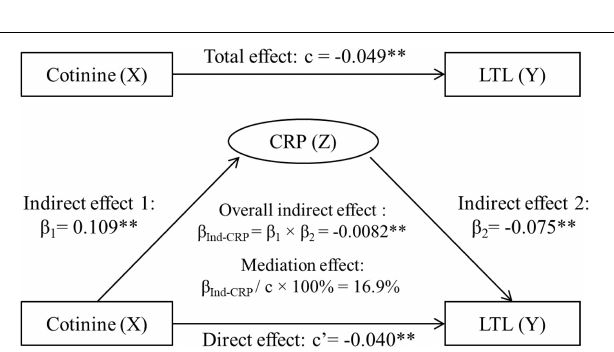
FIGURE 2 | Third variable model of serum cotinine, CRP and LTL, adjusting for age, race, sex, physical activity, and alcohol drinking. β , c, and c’ are standardized regression coefficients. c, total effect; c’, direct effect; β 1 , indirect effect 1; β 2 , indirect effect 2; β Ind − CRP , overall indirect effect; CRP, C-reactive protein; LTL, leukocyte telomere length. ∗∗ p < 0.01 for β , c, and c’ being different from 0. In the case of |c| > | β Ind − CRP |: Total effect (c) = Direct effect (c’) + Indirect effect ( β Ind − CRP ). − 0.0486 = − 0.0404 + ( − 0.0082), |c| > |c’|, then β Ind − CRP has a mediation effect.